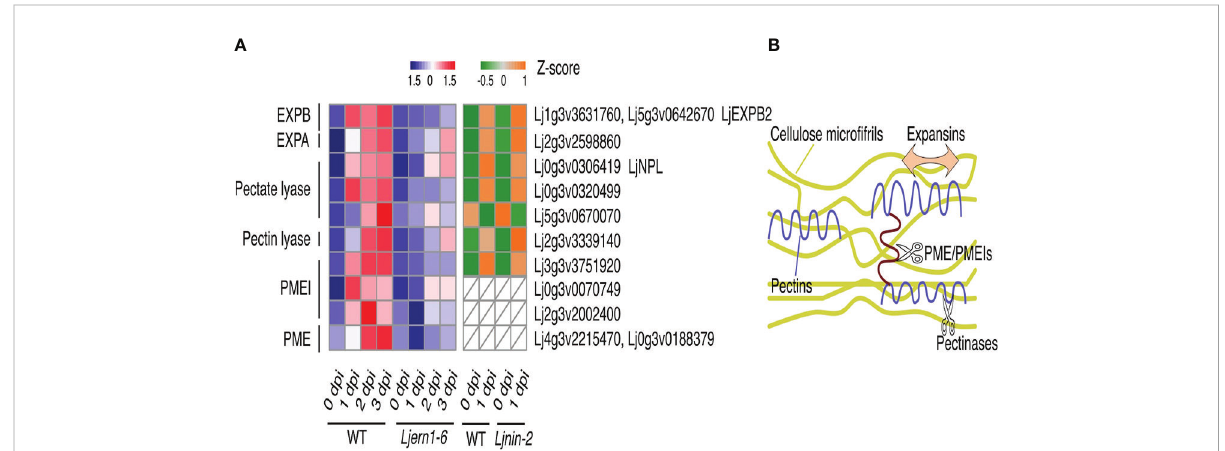
FIGURE 2 Cell wall-associated DEGs in WT plants and mutants. (A) Heatmap showing the expression levels of cell wall-associated DEGs in the WT and mutants at different time points. Left grid, Z-scores of genes in the WT (MG-20) and Ljern1-6 mutants at 0, 1, 2, and 3 dpi; right grid, Z-scores of genes in the WT (Gifu) and Ljnin-2 mutants at 0 and 1 dpi. (B) Illustration of the role of expansins, PEMs, PMEIs, and pectinases in the cell wall modi fi cation